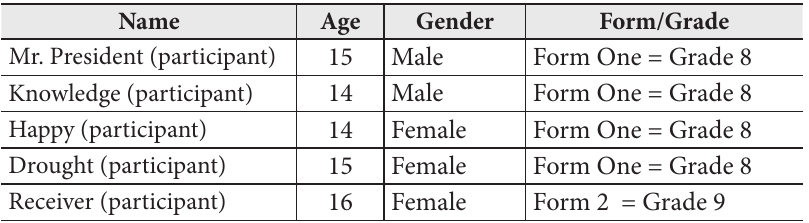
Table 1: Participants and Informants